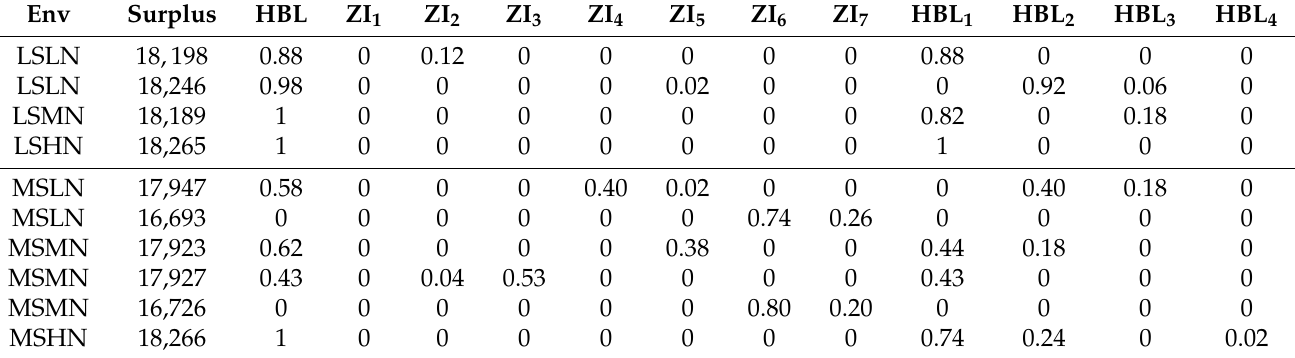
Table A5. Equilibria for games without spoofing, N = 28, calculated from the four-player DPR approximation. Each row of the table describes one equilibrium found with its corresponding surplus, HBL adoption rate and the equilibrium mixture probabilities of strategies